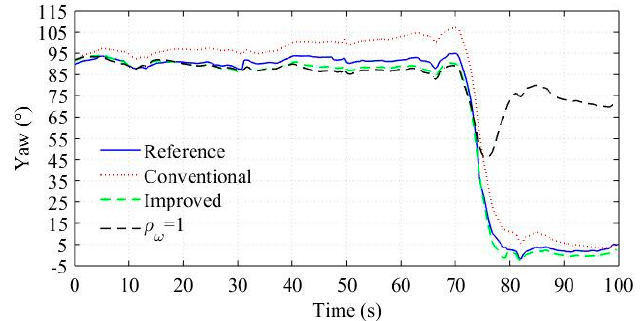
Figure 5. Yaw estimation.